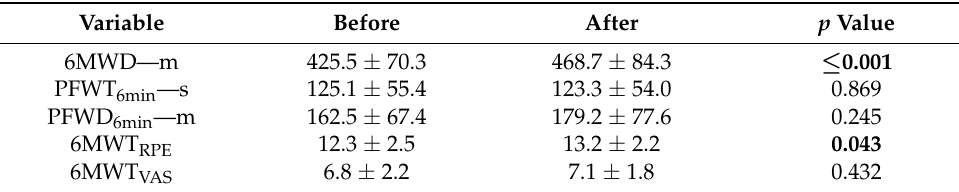
Table 2. 6 min walk test before and after supervised exercise